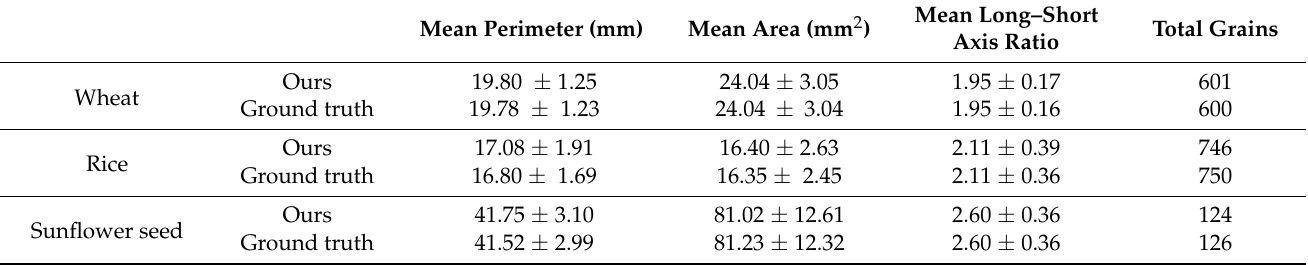
Table 2. The average size distributions of our segmented instances and the manually sketched